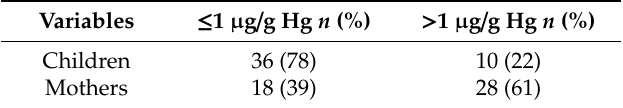
Table 1. Mothers and children with mercury levels below and above 1 µ g / g Hg.